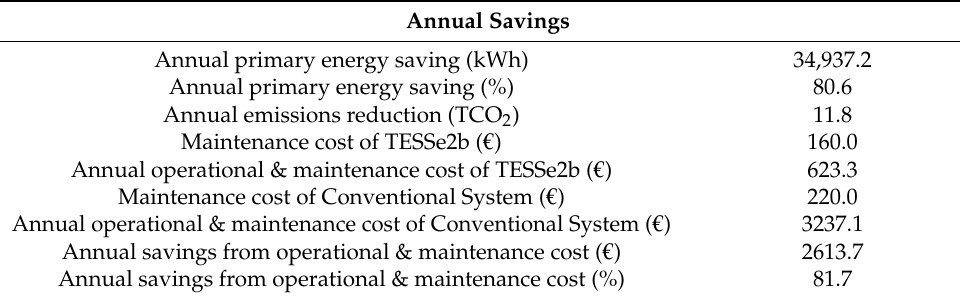
Table 4. Annual savings.